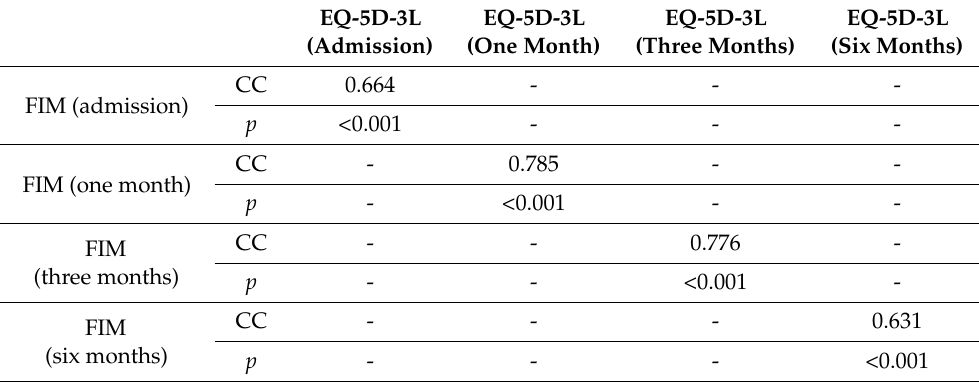
Table 6. Correlation analysis between FIM and